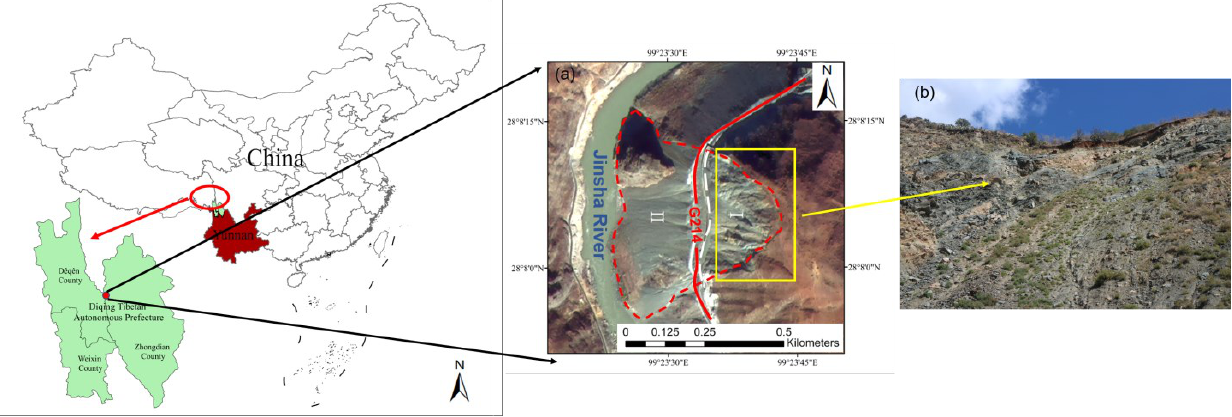
Figure 1. The location and Google Earth image of Jizong Shed-Tunnel landslide. ( a ) Optical GF-1 fused true color image; ( b ) Site investigation image. fused true color image; ( b ) Site investigation